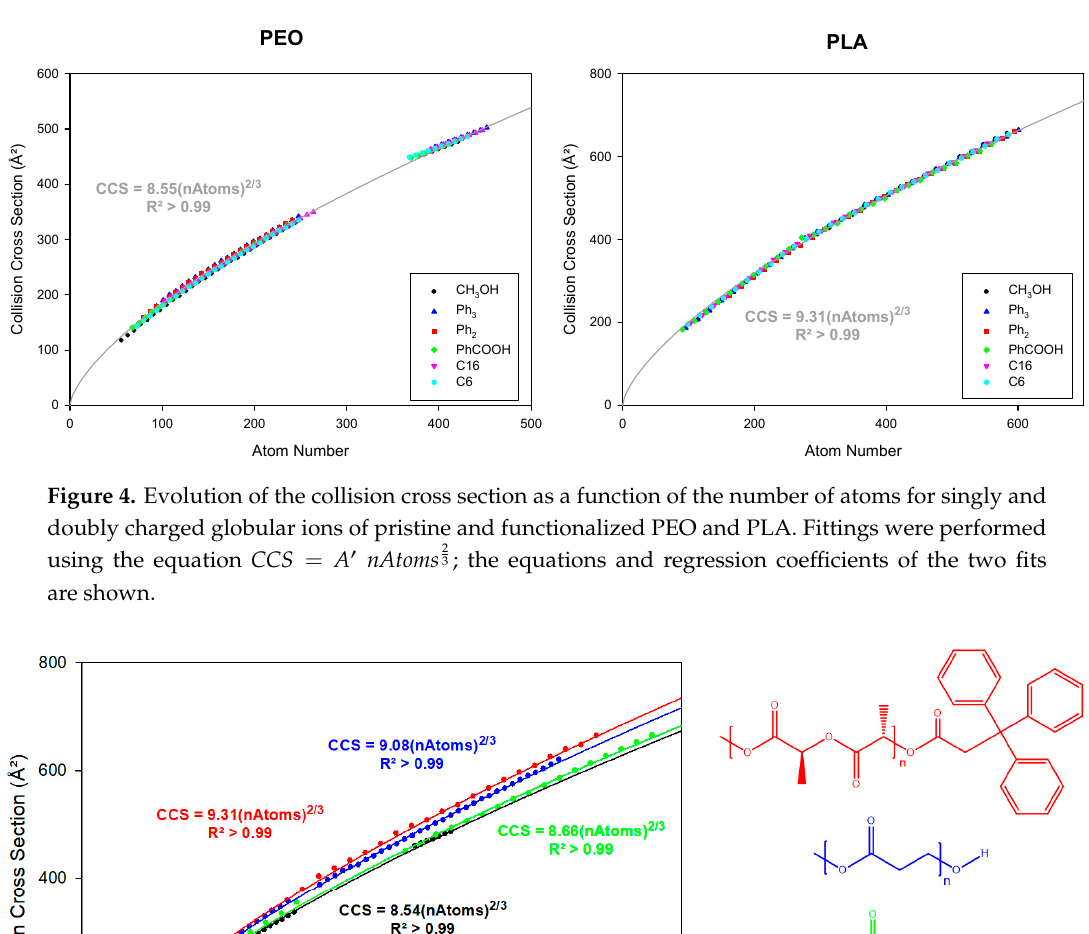
Table 3. Collision cross section evolution as a function of the atom numbers—parameters obtained (cid:3118) from fitted curves for a (cid:1829)(cid:1829)(cid:1845) = (cid:1827) (cid:4593) (cid:1866)(cid:1827)(cid:1872)(cid:1867)(cid:1865)(cid:1871) (cid:3119) equation (See Figures S5 and S6).